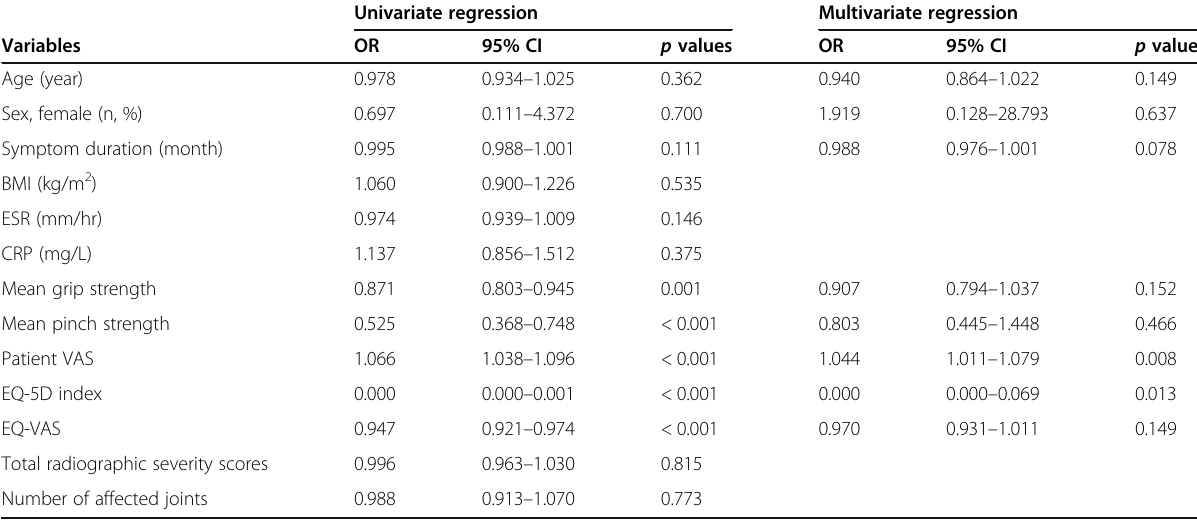
Table 3 Determination of variables related with high FIHOA score Univariate regression Multivariate